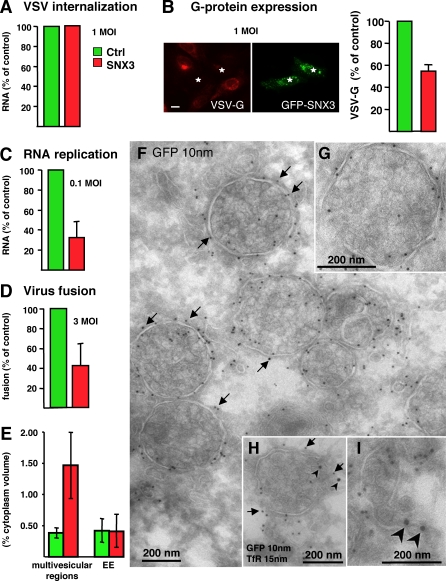
SNX3 in VSV Infection and MVB Biogenesis(A) VSV (1 multiplicity of infection [MOI]) was bound on ice to the surface of control HeLa cells (ctrl) or HeLa cells expressing GFP-SNX3. Cells were incubated for 15 min at 37 °C to allow VSV internalization. Then, total endosomes were prepared by fractionation and viral RNA was quantified by RT-PCR. Values are expressed as a percentage of untransfected controls.(B) Experiments were as in (A), except that cells were incubated for 3 h, instead of 15 min, at 37 °C to allow VSV infection to proceed. Cells were analyzed by immunofluorescence with antibodies against VSV-G protein (left panels); stars indicate cells expressing GFP-SNX3 and not VSV-G. The total number of cells expressing the G-protein was counted and is expressed as a percentage of the controls (≈60% of untransfected control cells were infected).(C) Experiments were as in (B), except that 0.1 MOI VSV was used and viral RNA replication was quantified by RT-PCR. Values are expressed as a percentage of untransfected controls.(D) Experiments were as in (A), except that 3 MOI Dil-labeled VSV was used and that cells were incubated for 35 min at 37 °C. Then, viral fusion events were visualized as fluorescent spots (due to Dil dequenching) by fluorescence microscopy, and quantified. Values are expressed as in (B).(E) Control HeLa cells (Figure S6A) or cells expressing GFP-SNX3 (Figure S6B) were fixed and embedded in Epon. Random fields of the different areas in one section were captured at 25.000× magnification (the procedure was repeated 3× for controls and 5× after GFP-SNX3 overexpression). Early endosomes (EE) were identified as vacuole of 200–500 nm containing five or fewer clearly defined internal vesicles, and multivesicular regions as vacuole of 200–500 nm containing five or more clearly defined spherical internal vesicles [66]. The volume of EE and multivesicular regions was calculated by stereological means, and the mean values are expressed as a percentage of the cytoplasm volume ± standard error of the mean (SEM).(F–I) HeLa cells expressing GFP-SNX3 were analyzed by electron microscopy after immunogold labeling of cryosections using antibodies against GFP ([F–H], arrows) and the transferrin receptor (TfR) ([H and I], arrowheads) followed by proteinA-gold, as indicated.In (A–E), each condition is the mean of at least three independent experiments; standard errors are indicated.(B) Scale bar indicates 10 μm; (F–I) scale bar indicates 0.2 μm.